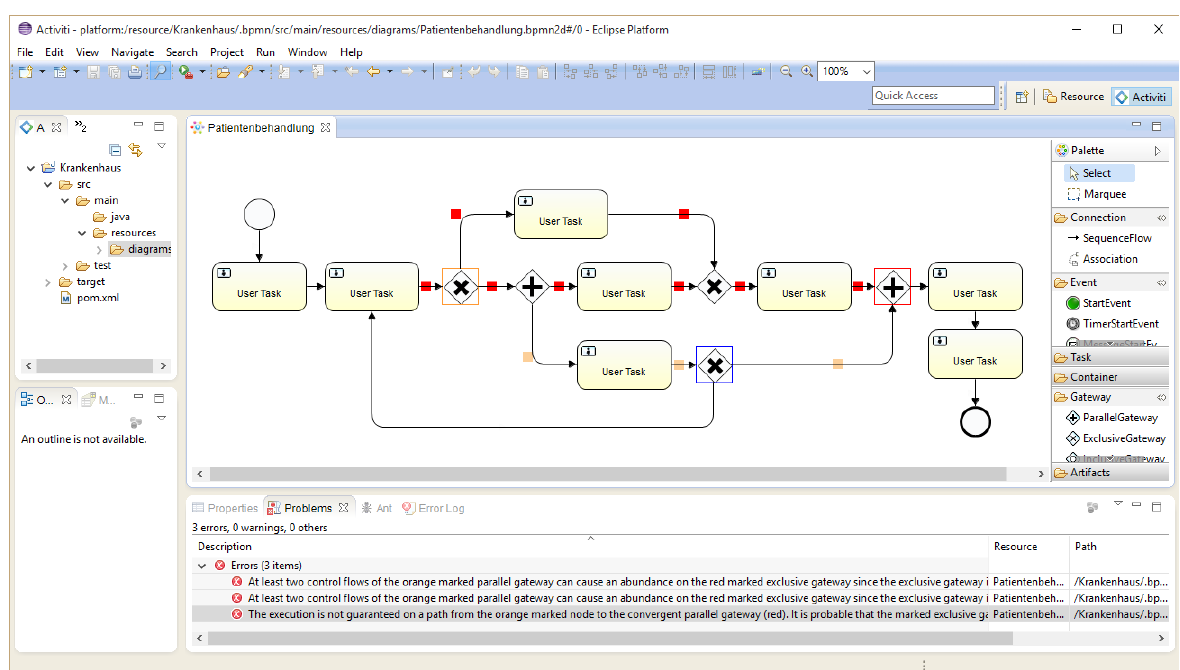
Figure 23. Integration of Mojo in the Activiti BPMN 2.0